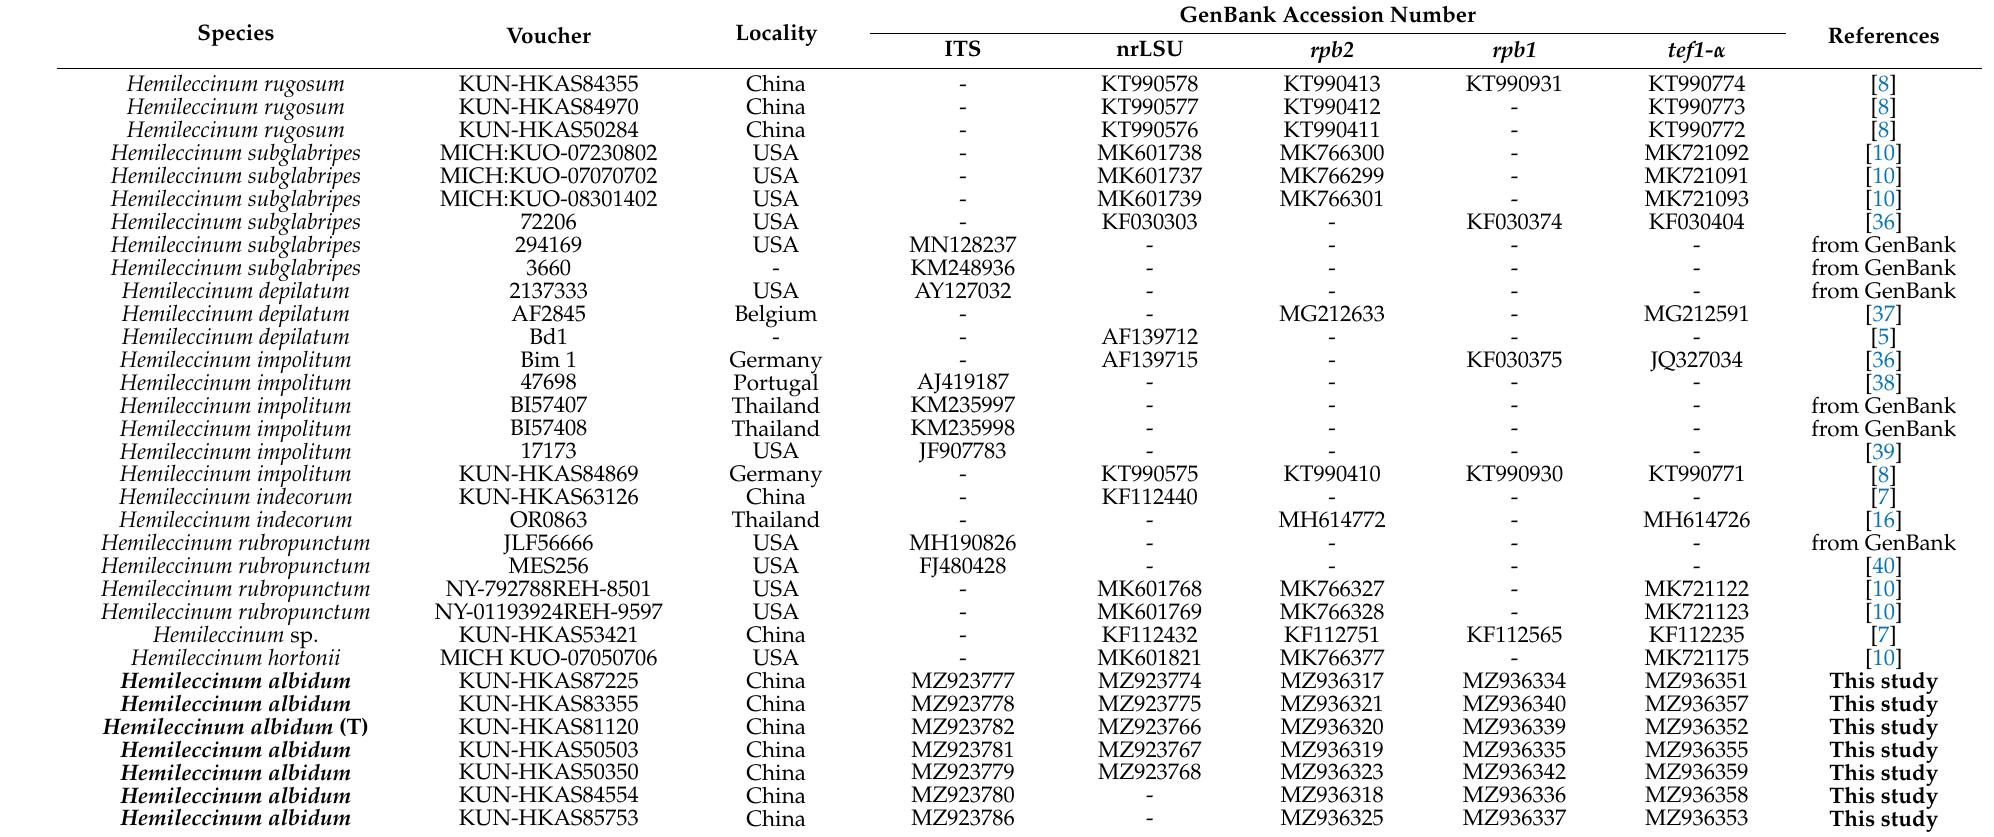
Table 1. Specimens used in phylogenetic analysis and their GenBank accession numbers. The newly generated sequences are shown in bold.